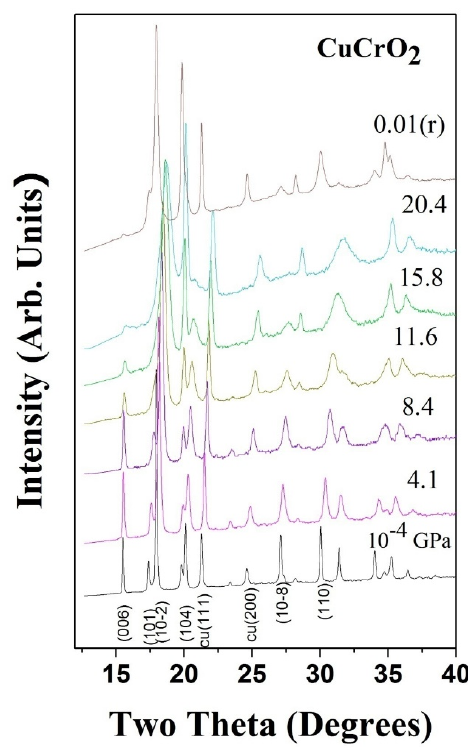
Figure 7. X-ray diffraction data at a few selected pressures for CuCrO 2 along with the released data. Diffraction peaks from in-situ pressure calibrant (Cu) are also indicated. Numbers denote the pressure in GPa.